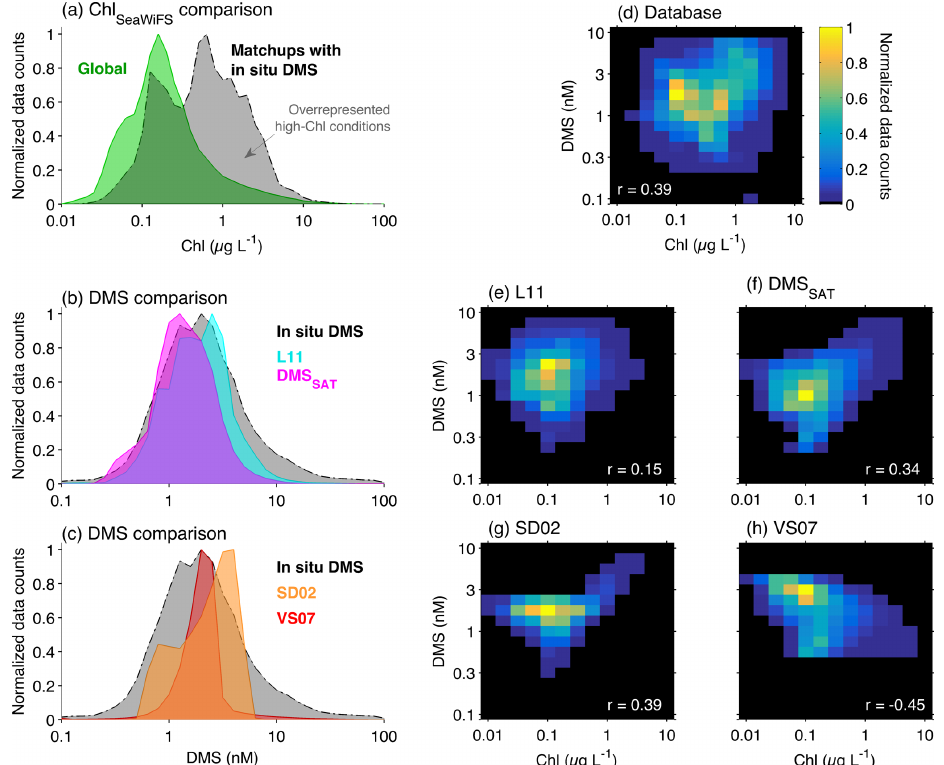
Figure 7. Histograms illustrating the relationship between DMS and Chl in the global ocean. (a) Global SeaWiFS 1997–2010 Chl SAT climatology and SeaWiFS Chl SAT matchups for the in situ DMS database; (b) Global L11 and DMS SAT climatologies and in situ DMS database; (c) Global SD02 and VS07 climatologies and in situ DMS database; (d) bivariate histogram of in situ DMS vs. corresponding SeaWiFS Chl SAT matchups; (e–h) bivariate histograms of the global SeaWiFS Chl SAT climatology vs. climatological DMS from (e) L11, (d) DMS SAT , (e) SD02 and (f) VS07 algorithms. In (d–h) , the correlation coefficient (Pearson’s r ) between DMS and Chl in each dataset is super-imprinted in